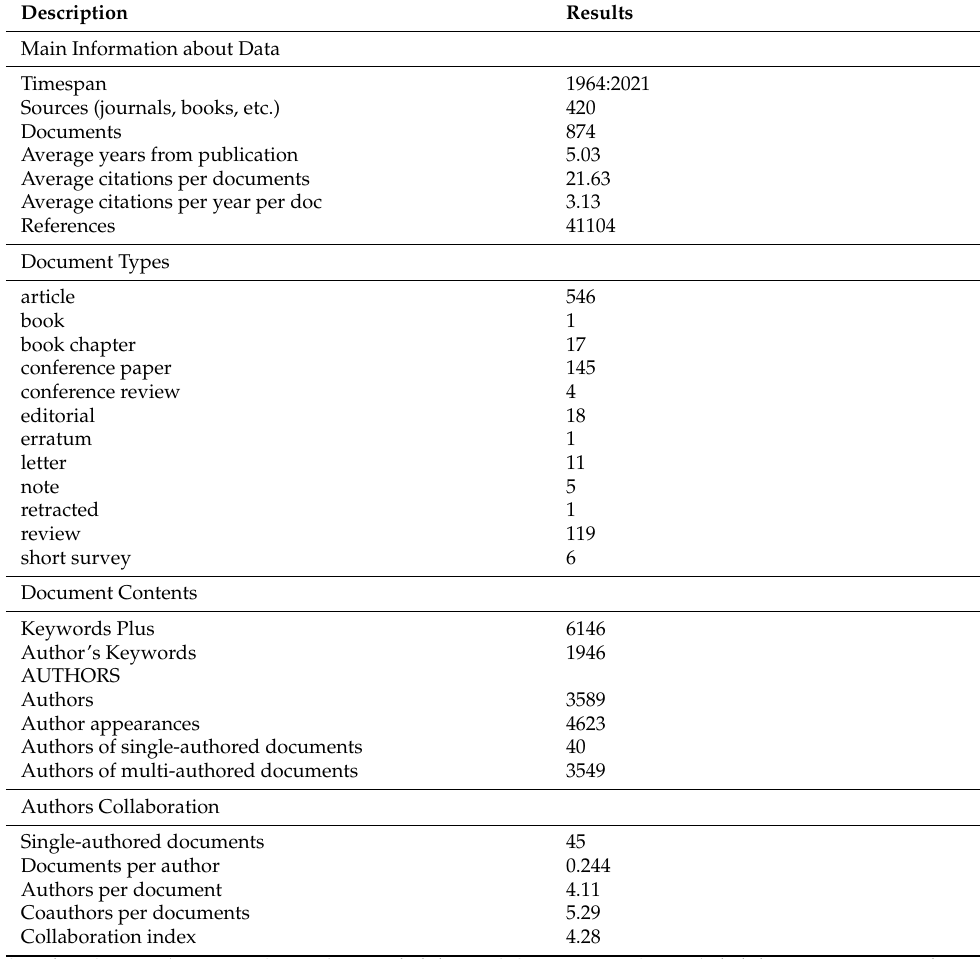
Table 1. Main bibliometric characteristics of documents retrieved from